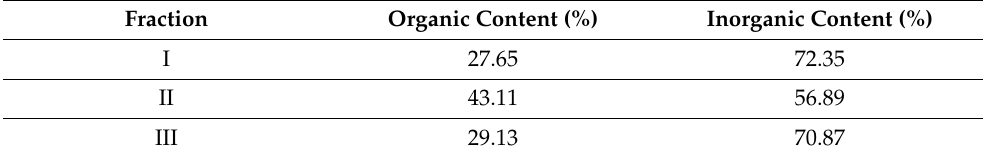
Figure 2. Wind turbine waste fractions subjected to a firing process at 600 °C, for 12 h: ( a ) rotor blade aerodynamic part—fraction I; ( b ) turbine blade monolithic part—fraction II; ( c ) rotor blade aerodynamic part—fraction III. Table 2. Organic and inorganic content for specific waste fractions from wind turbines.